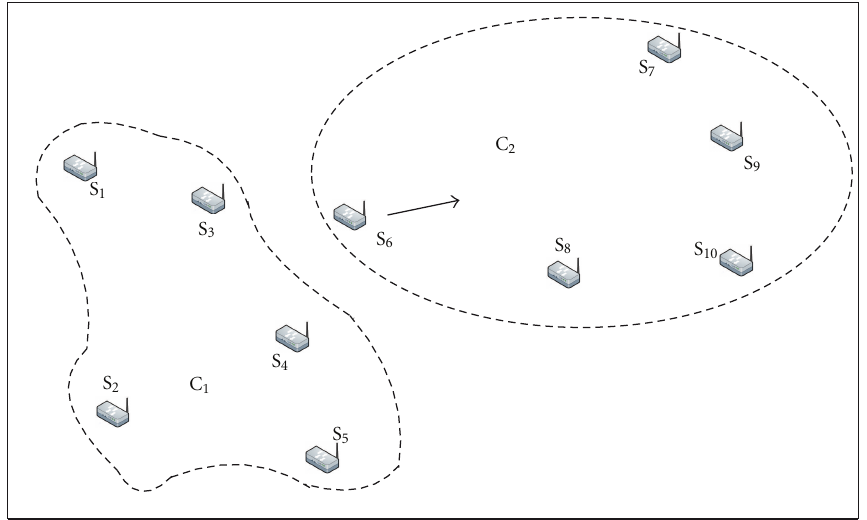
Figure 4: An example of the cluster balancing stage.